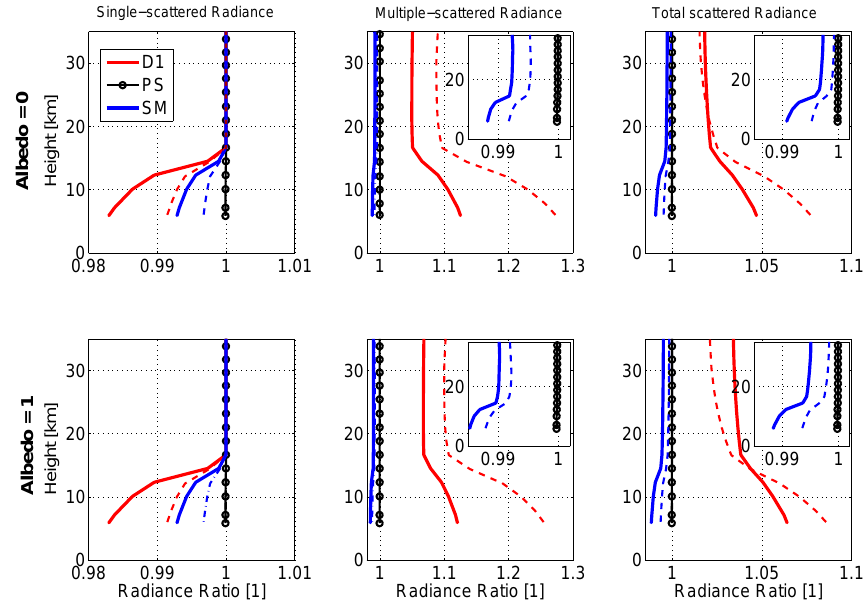
Fig. 11. A comparison of single-scattered, multiple-scattered and total scattered radiance at 337nm for absorbing dust (D1), pure soot (PS) and smoke (SM) at solar zenith angles of 65 ◦ (thick solid lines) and 87 ◦ (thinmer dashed lines). PS for low SZA is also distinguished with circle markers and completely obscures PS for high